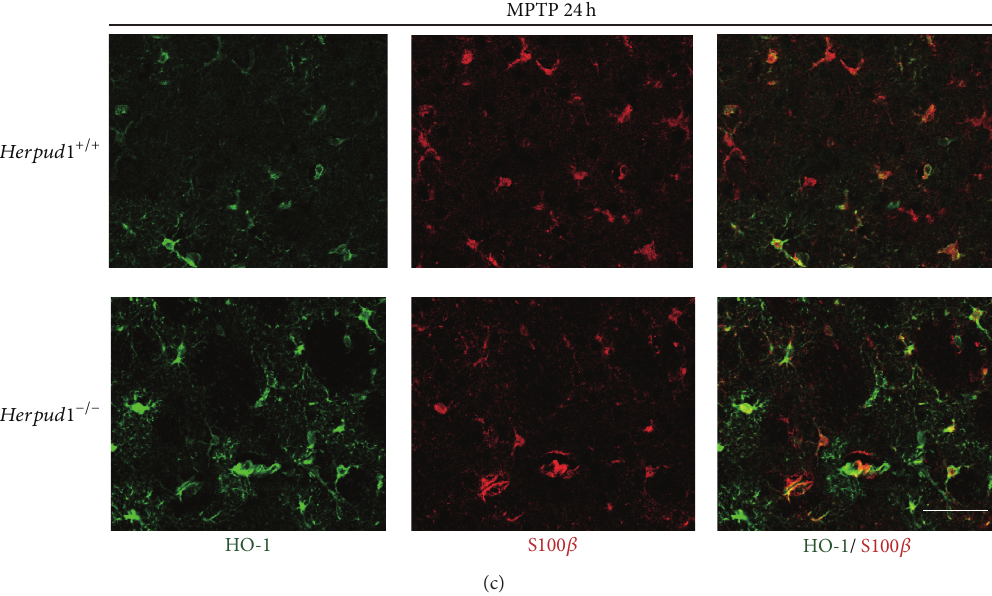
Figure 3: Expression of stress-related genes after MPTP administration. (a) qRT-PCR. (b) Western blots. Herpud1 +/+ and Herpud1 −/− mice were injected with MPTP, and the total RNA (1 𝜇 g) or protein samples (30 𝜇 g) extracted from the CPu were subjected to qRT-PCR (a) or western blotting ( 𝑛 = 4 ) (b). Each value shown is the mean ± SD, and the value derived from Herpud1 +/+ mice without MPTP administration is designated as one. ∗ 𝑃 < 0.05 ; ∗∗ 𝑃 < 0.01 , compared to mice without MPTP administration. # 𝑃 < 0.05 ; ## 𝑃 < 0.01 between the two genotypes. (c) Immunohistochemistry. Herpud1 +/+ and Herpud1 −/− mice were injected with MPTP and perfused with 4% paraformaldehyde after 24 h. Brain sections were subjected to immunohistochemistry with anti-HO-1 and anti-S100 𝛽 antibodies. Scale bars = 50 𝜇 m